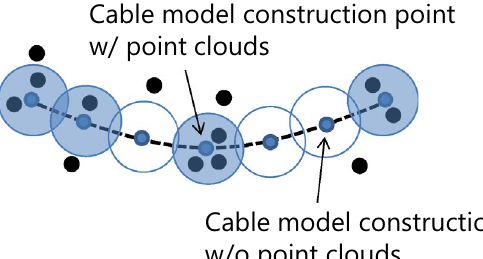
Fig. 4 Cable-model-construction point used to determine degree of inclusion of point clouds. A model with many cable-model-con- struction points including a point cloud is similar to an actual